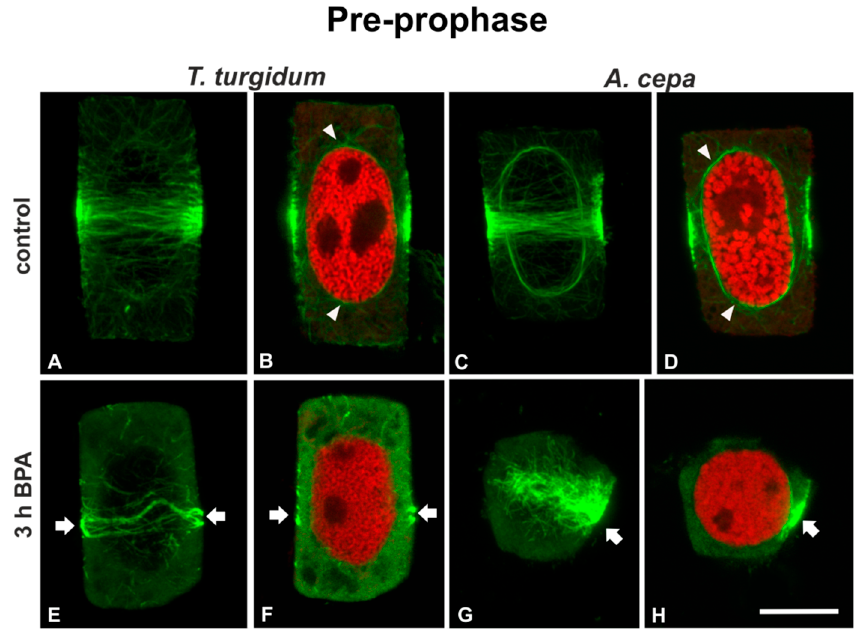
Figure 2. ( A , C , E , G ) Tubulin immunolocalization (green, projections of CLSM sections) and ( B , D , F , H ) propidium iodide DNA staining (red, single CLSM sections) in pre-prophase root cells. Arrows point to aberrantly organized pre-prophase microtubule bands of BPA-affected cells. Note the absence of perinuclear microtubules in ( F ) and ( H ) in contrast with the control (arrowheads in ( B ) and ( D )). Scale bar: 10 μ m.